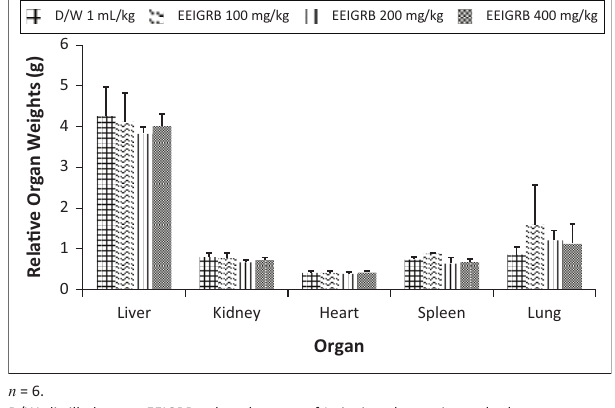
n = 6. Note: Values are expressed as mean ± standard error of mean. There were no significant differences between values for control and treatments groups (distilled water).